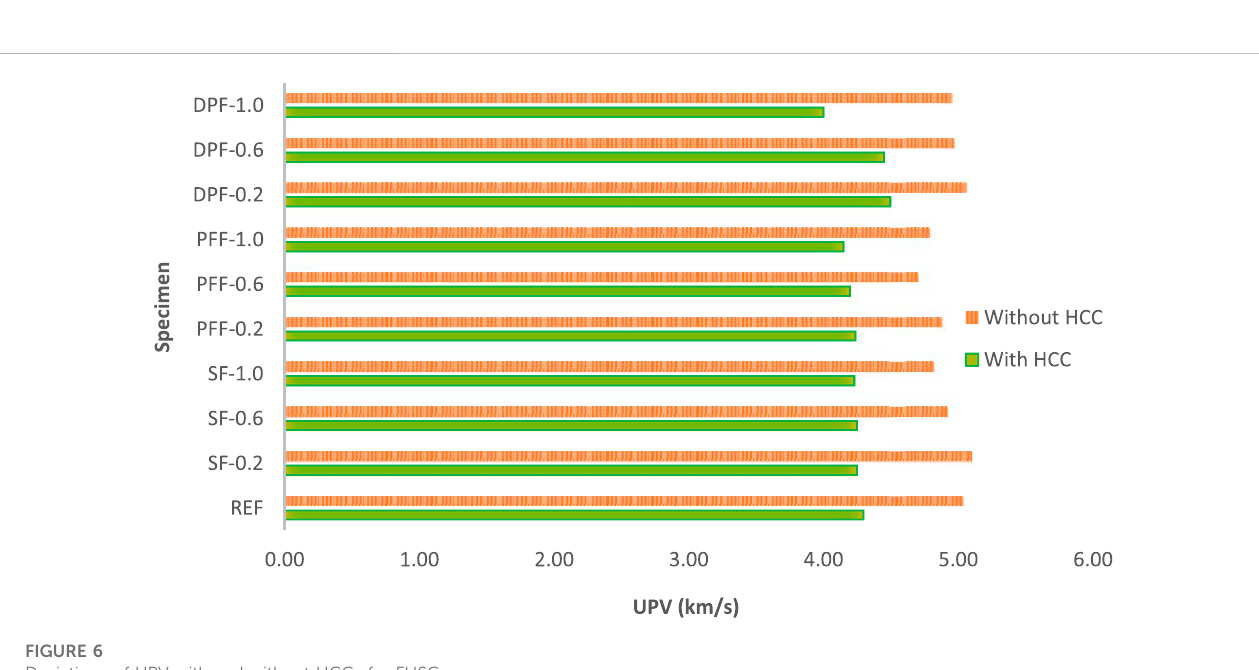
FIGURE 5 Behaviour toughness of FHSC with-and-without HCCs.